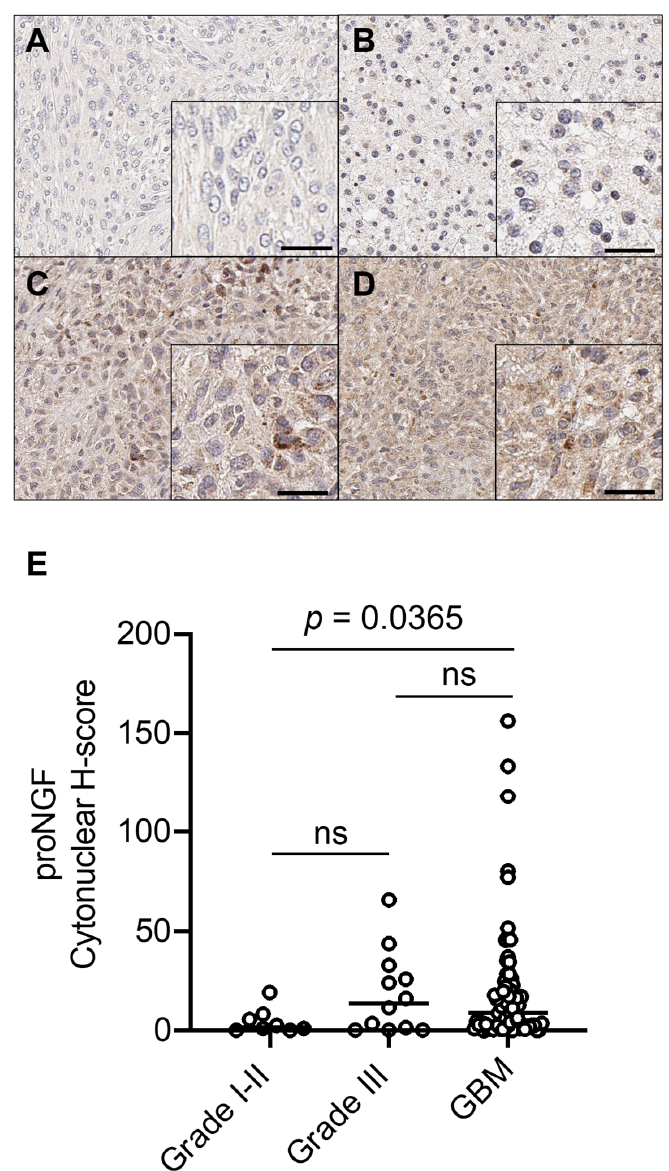
Figure 1. ProNGF expression in GBM vs. low grade gliomas. Immunohistochemical detection of proNGF, representative pictures are shown for ( A ) grade I, ( B ) grade II, ( C ) grade III gliomas, and ( D ) GBM. ( E ) Digital quantification of proNGF staining intensities according to grouped patholog ‐ ical subtypes: grade I–II (h ‐ score = 1.98, IQR 0.50–7.73), grade III (h ‐ score = 13.93, IQR 0.74–31.15)